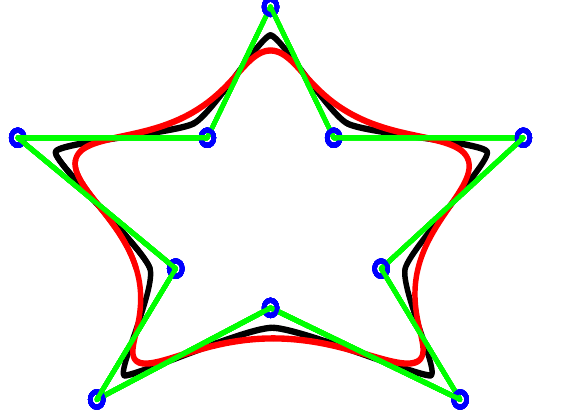
Figure 18. Star designing using rational B-spline curves.